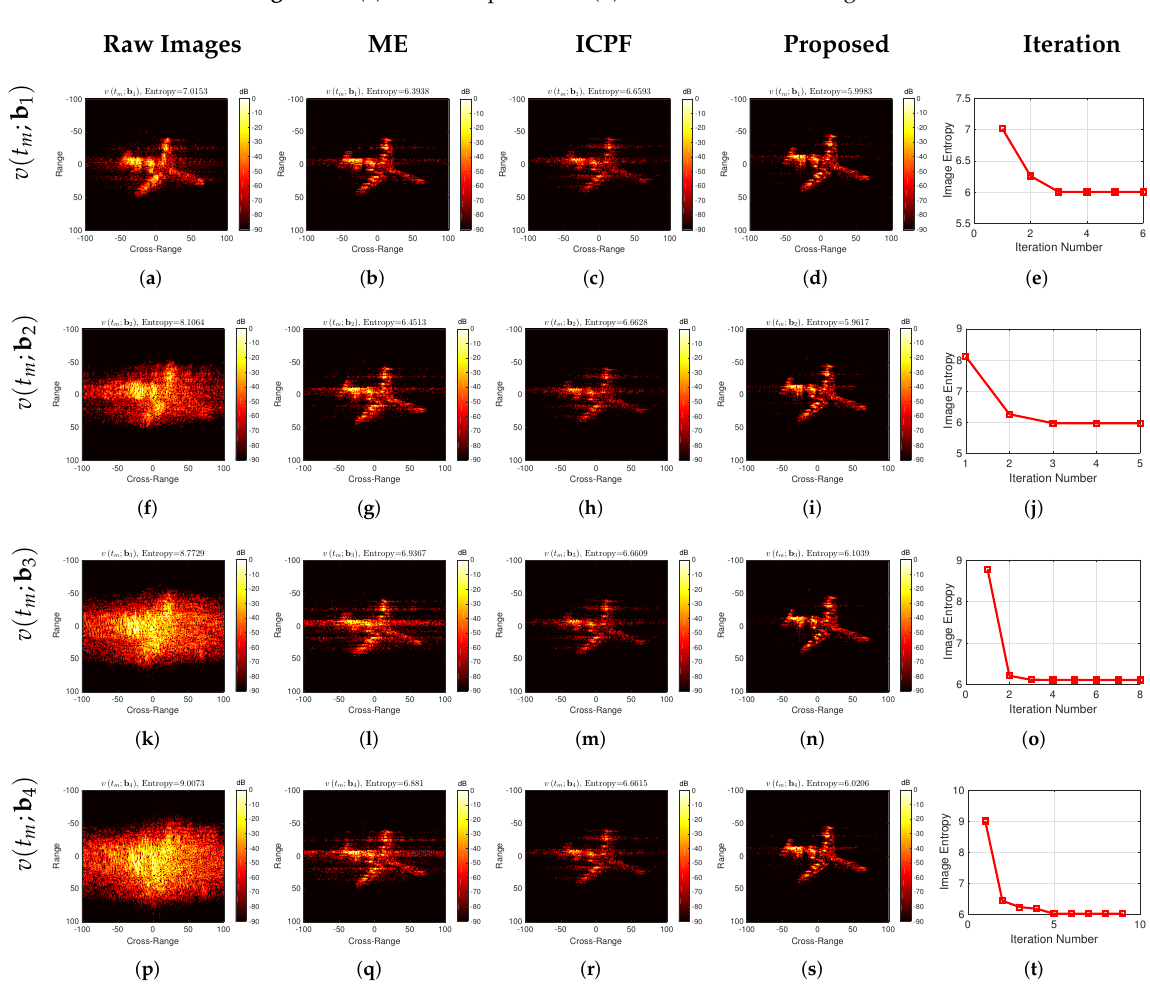
Figure 14. Experimental results of Yak-42 measured data under different motion conditions. The leftmost column is the imaging results without high-speed motion compensation; the second column is the high-speed compensation imaging results by ME; the third column is the high-speed compen- sation imaging results by ICPF; the fourth column is the high-speed compensation imaging results of the proposed algorithm; the rightmost column is the image entropy against the iteration number of the proposed